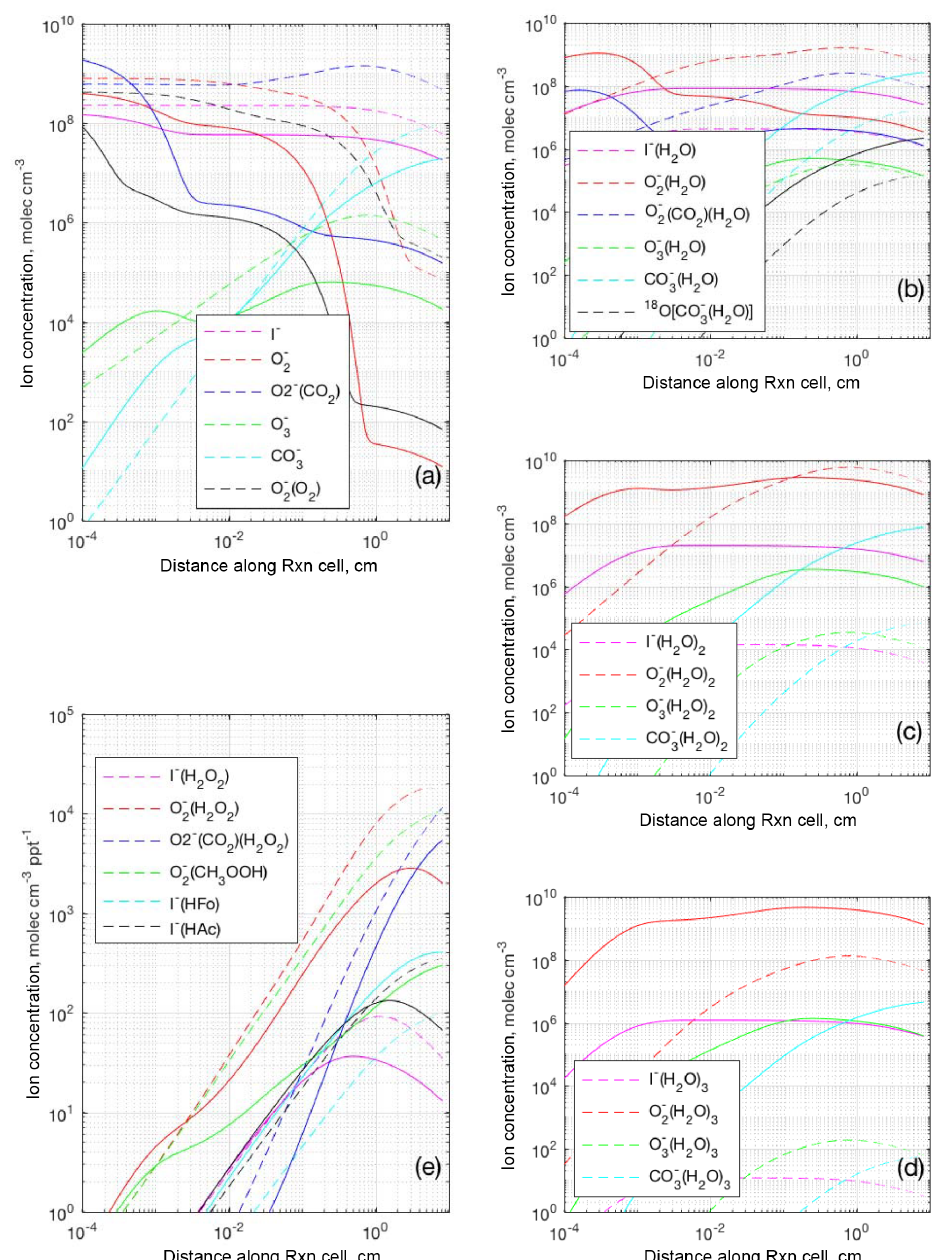
Figure 4. Simulated ion cluster densities along the reaction cell path for ambient pressure of P a = 307hPa and reaction cell H 2 O = 133ppm (dashed line) or P a = 1013hPa and reaction cell H 2 O = 9706ppm (solid line). Ambient O 3 was set equal to 50ppb for both pressures. Reaction cell time of transit is t x = 17.8ms. (a) Unhydrated reagent ion density. (b) First-hydrate reagent ion density. (c) Second-hydrate reagent ion densities. (d) Third-hydrate reagent ion densities. (e) Ion–analyte cluster ion density–arbitrary